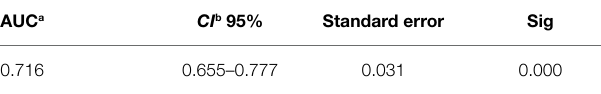
TABLE 9 | ROC curve parameters (teaching